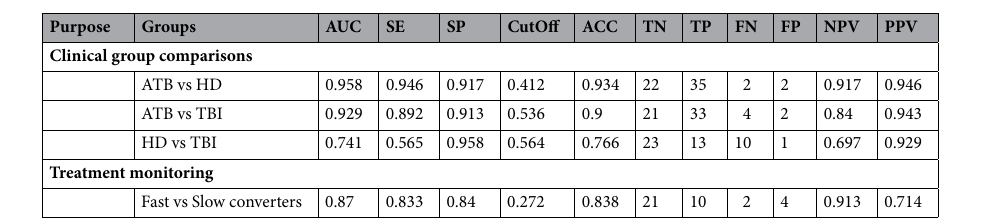
Table 2. Performance of CLEC3B-ECM1-IP10-SELL signature for comparison of clinical groups and TB treatment monitoring. AUC area under the ROC curve, SE sensitivity, SP specificity, PPV positive predictive value, NPV negative predictive value, ACC